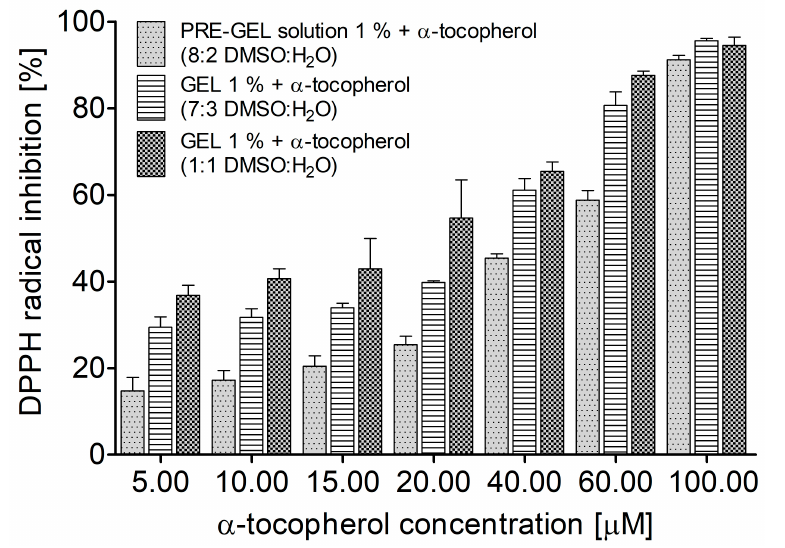
Figure 4. DPPH radical inhibition (%) by α -tocopherol in gel with 1% w / v of Boc-L-DOPA(Bn) 2 -OH and different ratios of DMSO/H 2 O (mean value ± SD, n =